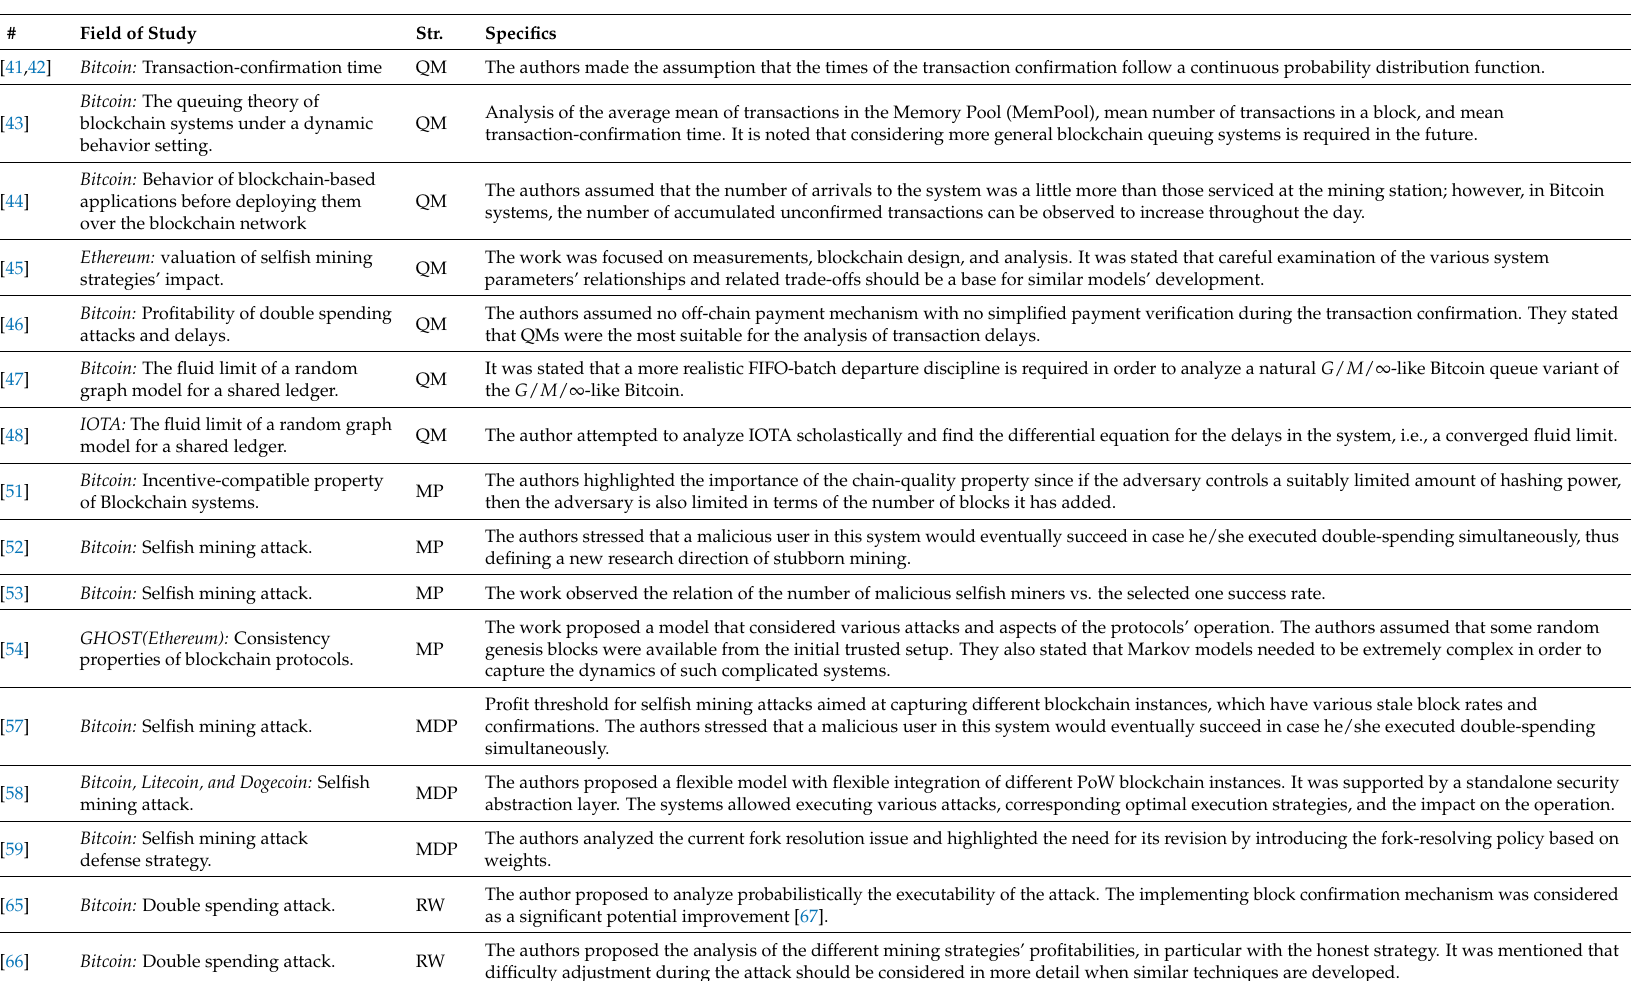
Table 2. State-of-the-art of the blockchain evaluation analytical and simulation